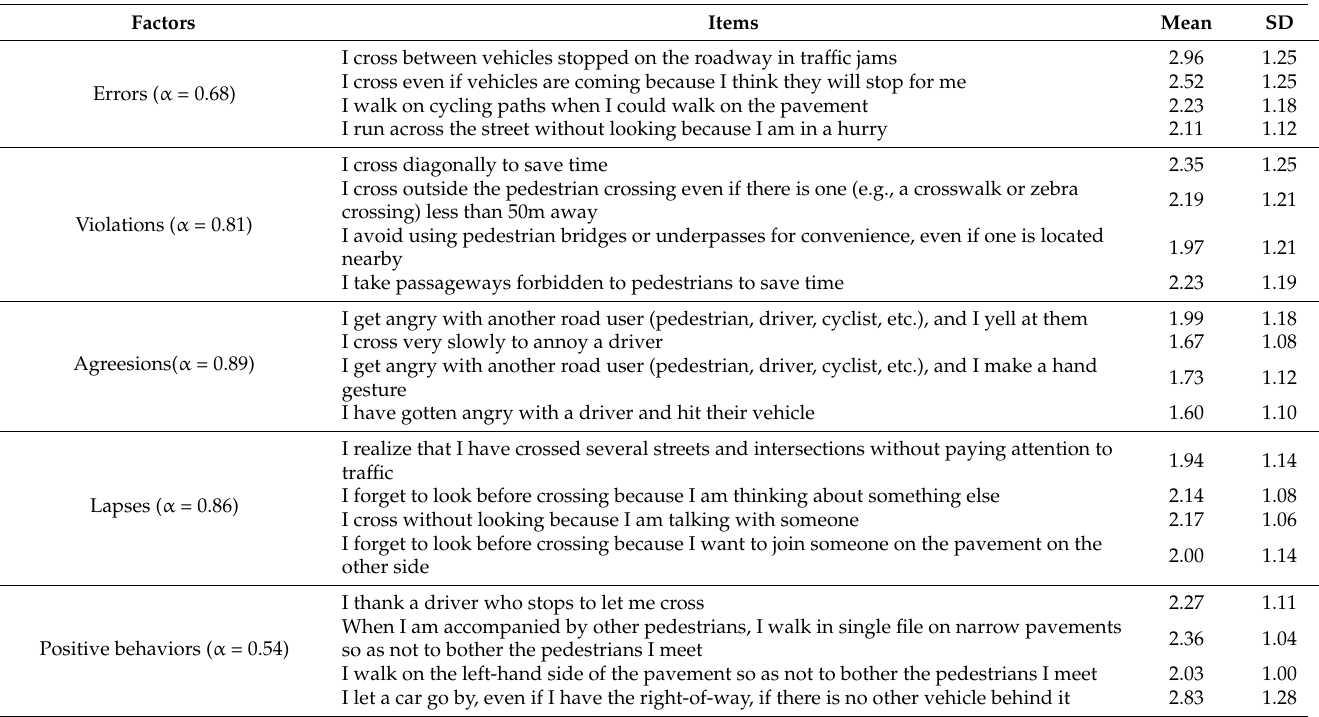
Table 5. The alpha values, means and standard deviations for the Pedestrian Behavior Questionnaire